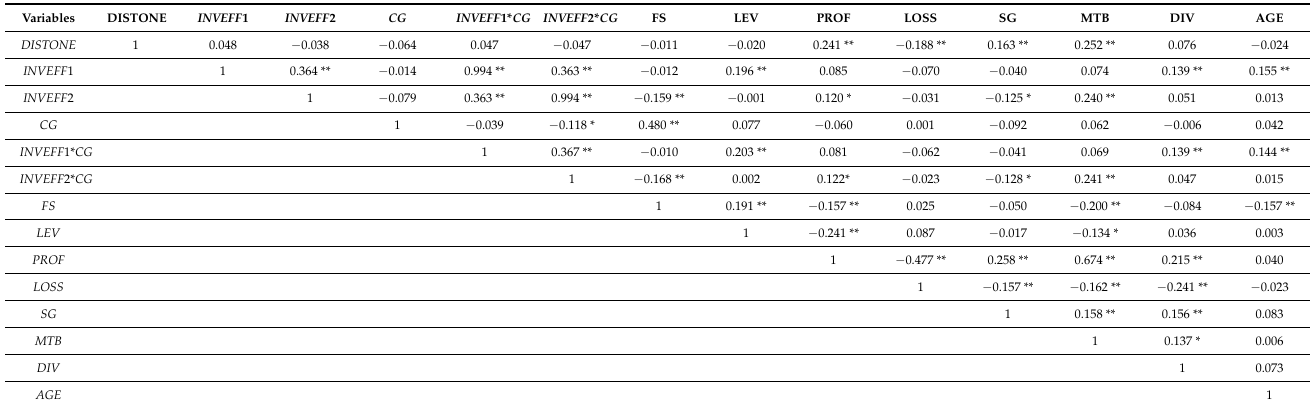
Table 4. Pearson’s Correlation Matrix: Disclosure Tone